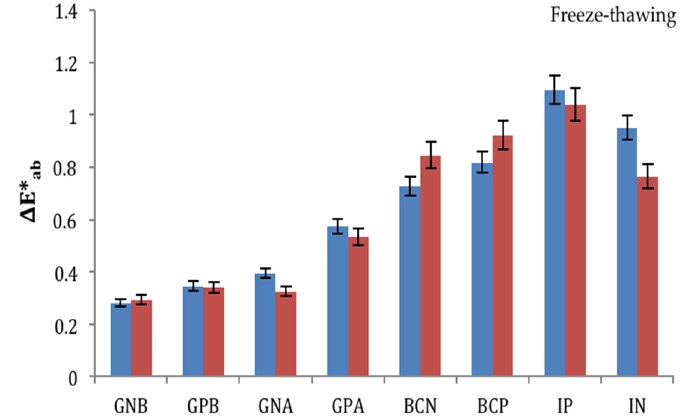
Figure 5. Total colour changes ( Δ E * ab ) in the accelerated ageing induced by freeze ‐ thawing cycles. Blue bars represent the differences after 10 cycles. Orange bars represent the differences after 20 cycles. The sample codes are explained in Table 1.